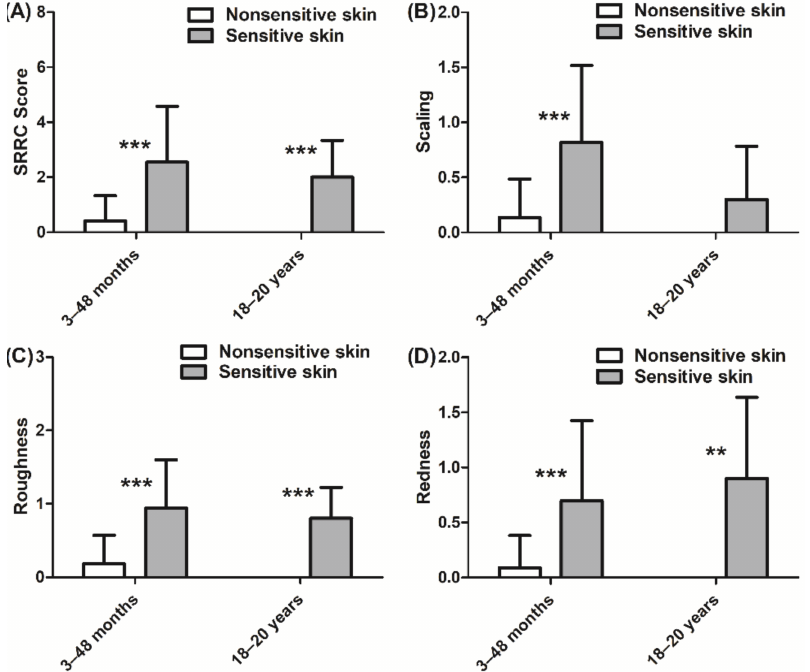
Figure 2. Clinical evaluation of nonsensitive and sensitive skin dryness according to SRRC (scaling, roughness, redness, and cracks) scores: ( A ) total SRRC score; ( B ) scaling score; ( C ) roughness score; ( D ) redness score. Scaling, roughness, and redness were absent in the nonsensitive skin group aged 18–20 years. Data are shown as the mean ± SD of all subjects in the group. ** p < 0.01, *** p < 0.001. In children, hydration was lower ( − 21%, p < 0.01, Figure 3A) in the sensitive skin group than in the nonsensitive skin group. By contrast, no significant difference in hydration was observed in adults. Furthermore, the barrier function, which was assessed via measurement of TEWL, was not different between the sensitive skin and nonsensitive skin groups in either children or adults (Figure 3B).